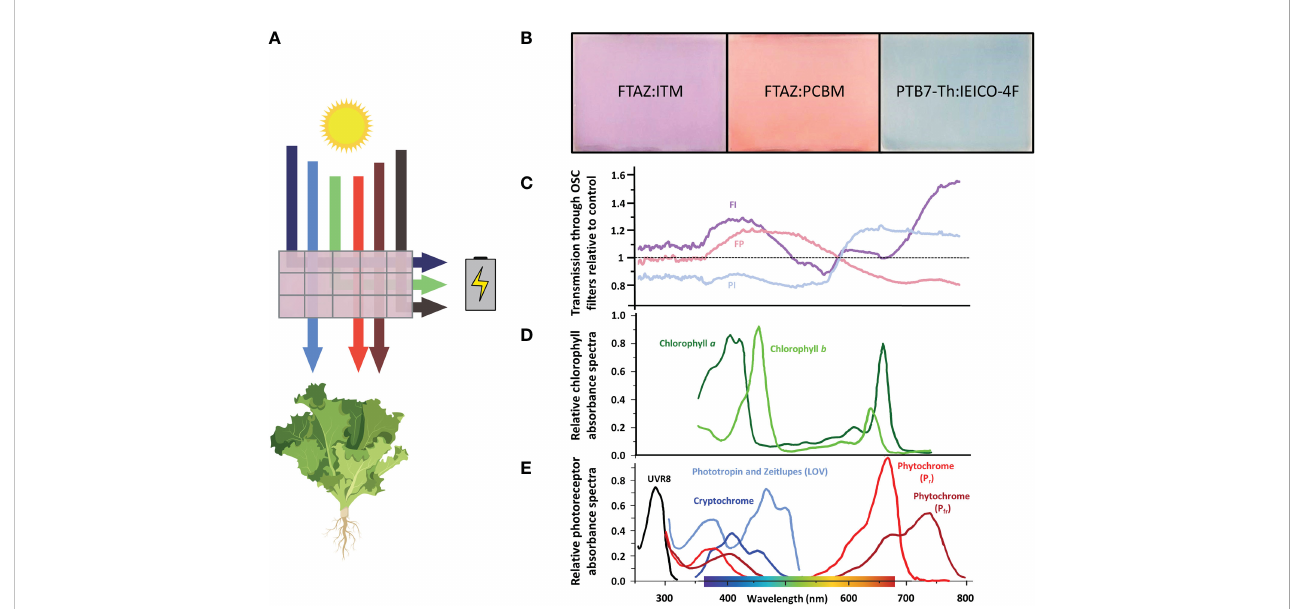
FIGURE 1 Wavelength selectivity of OSC devices. (A) Schematic of a wavelength-selective OSC device. Speci fi c wavelengths of light are harvested to generate electrical energy to power the greenhouse. The wavelengths most important for photosynthesis (blue, red and far-red) are selectively transmitted through the device to grow greenhouse crops. Created with BioRender.com. (B) The OSC fi lters are named for the two organic molecules that determine their color and transmission spectrum. Different donor and acceptor molecules can be chosen to tune the wavelengths that reach the plants below. (C) Ratio of light transmission through the OSC fi lters relative to the light transmitted through the control. Each fi lter varies in relation to the control and to each other over PAR and in the far-red region (700-750 nm). (D) Absorption spectra of plant chlorophylls. Chlorophyll a and b harvest light energy from sunlight to power photosynthesis over PAR (400-700 nm), especially in the blue and red regions (Kobayashi et al., 2013; Taniguchi and Lindsey, 2018; reviewed in Bilodeau et al., 2019). (E) Absorption spectra of photoreceptors. UVR8 absorbs UV light. Cryptochromes, phototropins and zeitlupes absorb primarily blue light. Phytochromes absorb red and far-red light (Taiz and Zeiger, 2022; Sager et al., 1988; Galvao and Fankhauser, 2015; reviewed in Bilodeau et al.,